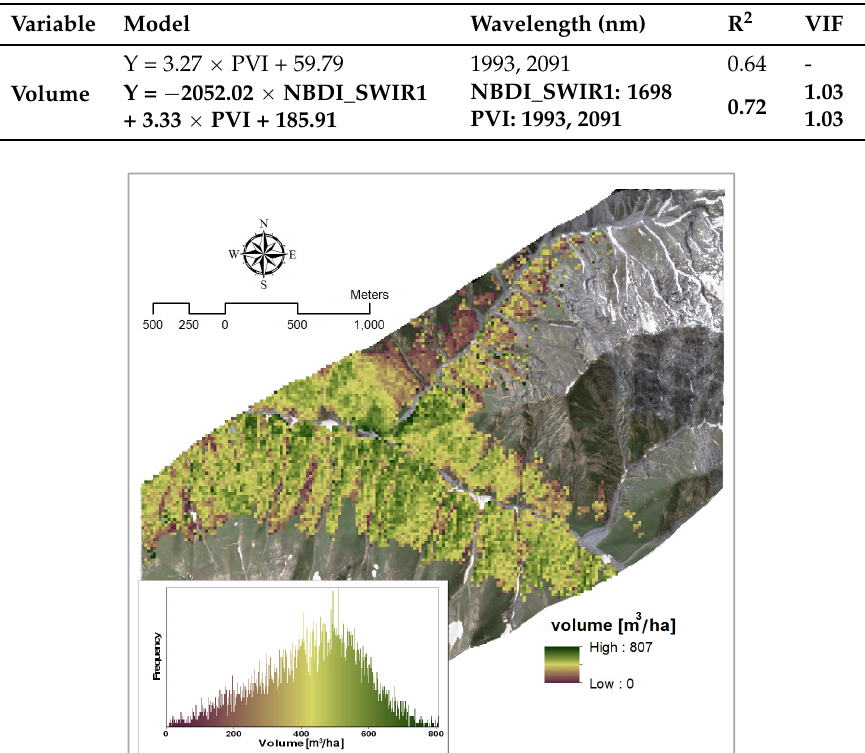
Table 5. Best performing simple and stepwise multiple regression models to estimate volume.